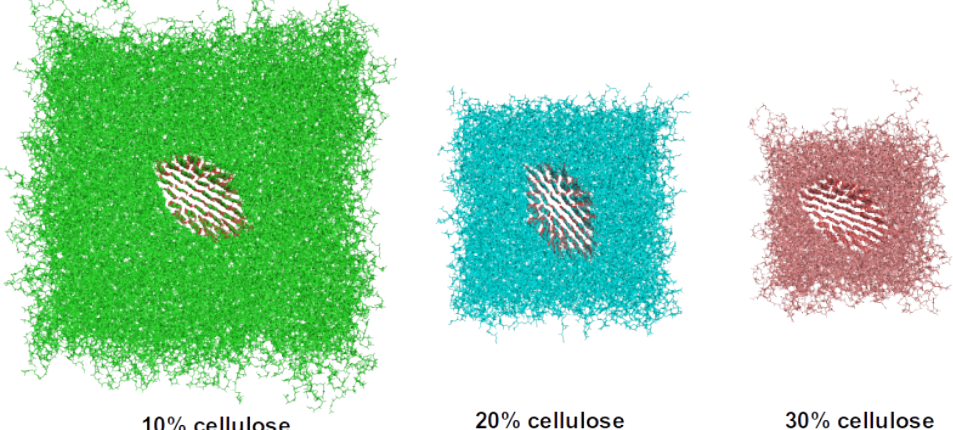
Figure 8. A view in the xy -plane on the CNF30-PP50 bionanocomposite models with varying cellulose ratios. Similar CNF30 fibril is in the middle of all models, and the PP chain length is 50 monomers. The x and y -dimensions of the simulation cells are different in each model, while the z -axis length is the same for all three models (approx. 15.5